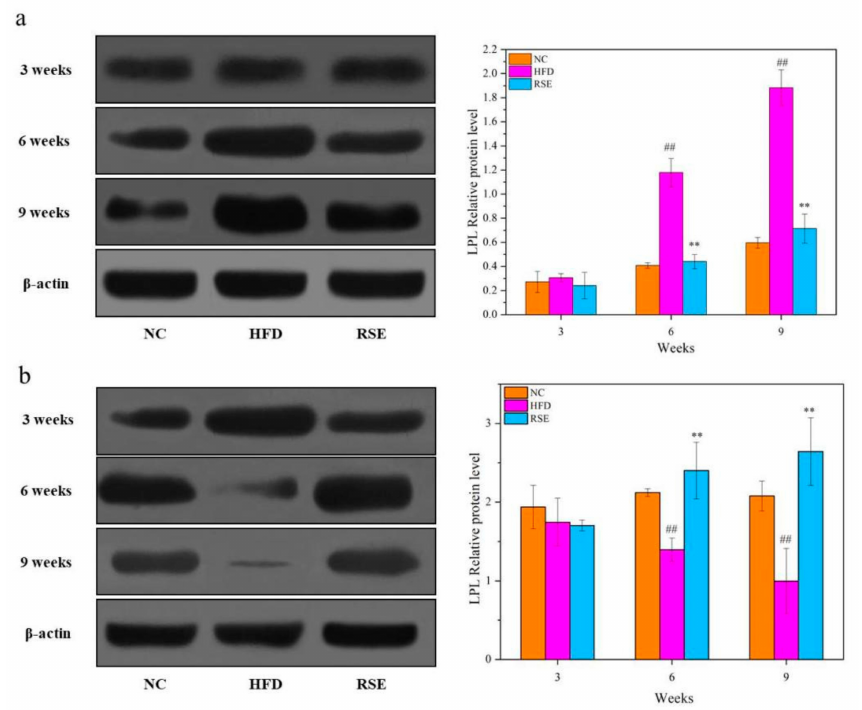
Figure 4. Effects of RSE on the LPL relative protein level in epididymal adipose tissue ( a ) and skeletal muscle ( b ). Data are expressed as the mean ± SEM. ## p < 0.01 for NC vs. HFD; ** p < 0.01 for RSE vs. HFD. Group abbreviations: refer to Figure 2 caption.